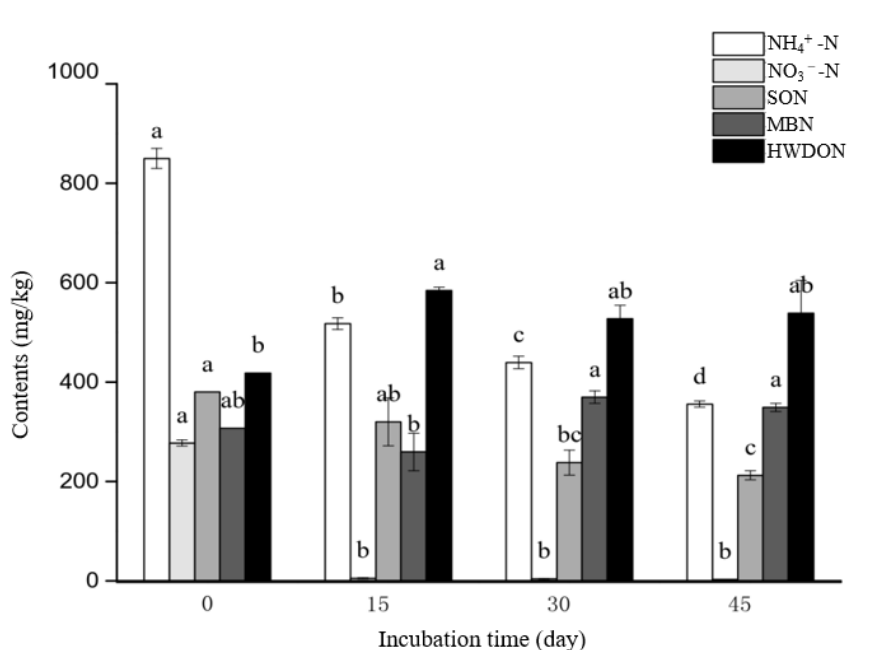
Figure 1. Contents of the available nitrogen fractions in the compost at different incubation times. SON, MBN, and HWDON indicate soluble organic nitrogen, microbial biomass nitrogen, and hot- water extractable organic N, respectively. Different letters indicate significant differences in a certain N fraction content between different stages ( p < 0.05). Data shown as the mean ± standard error ( n = 5).